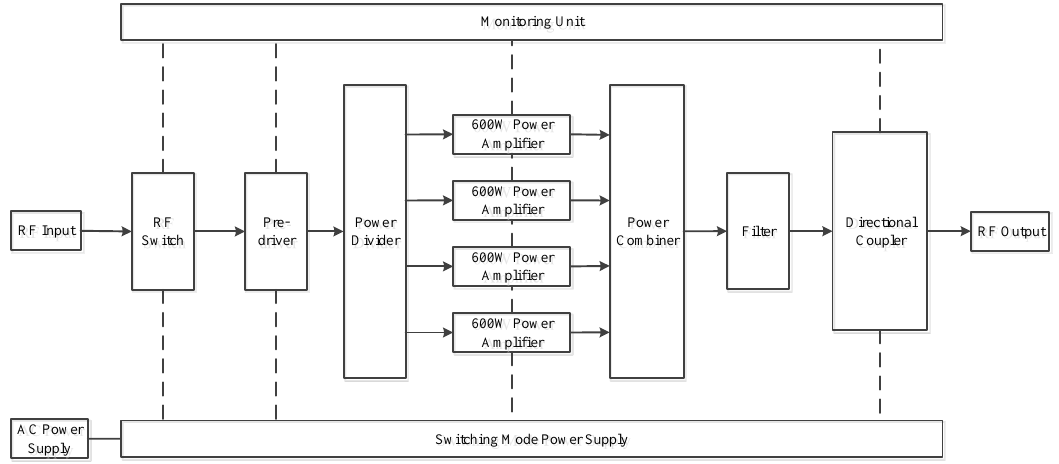
Figure 3. The block diagram of the power amplifier unit. 4 × 600 W linear amplifier can provide 2 kW transmission power.